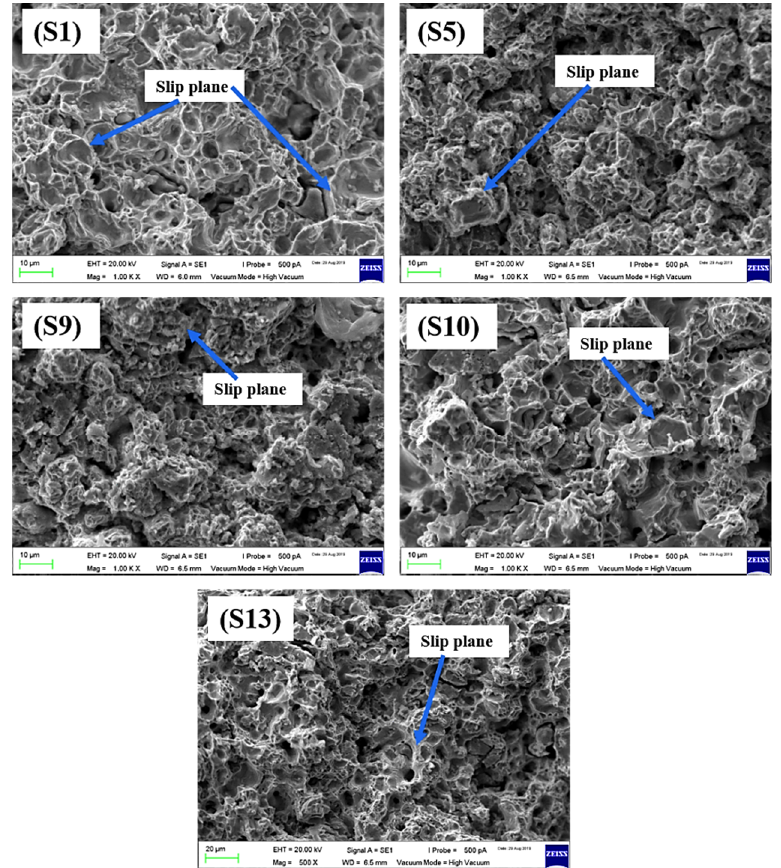
Figure 13. SEM images of tensile fracture